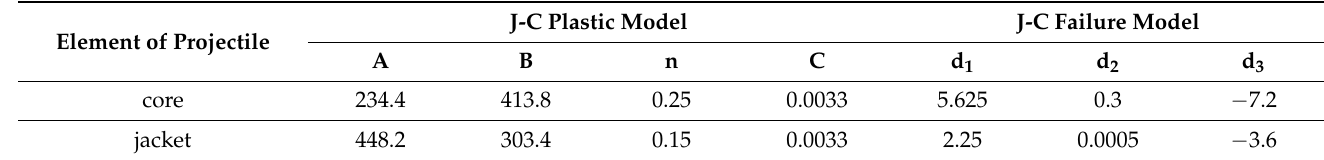
Table 2. Material properties for the core and jacket of the 7.62 mm ŁPS projectile [64].